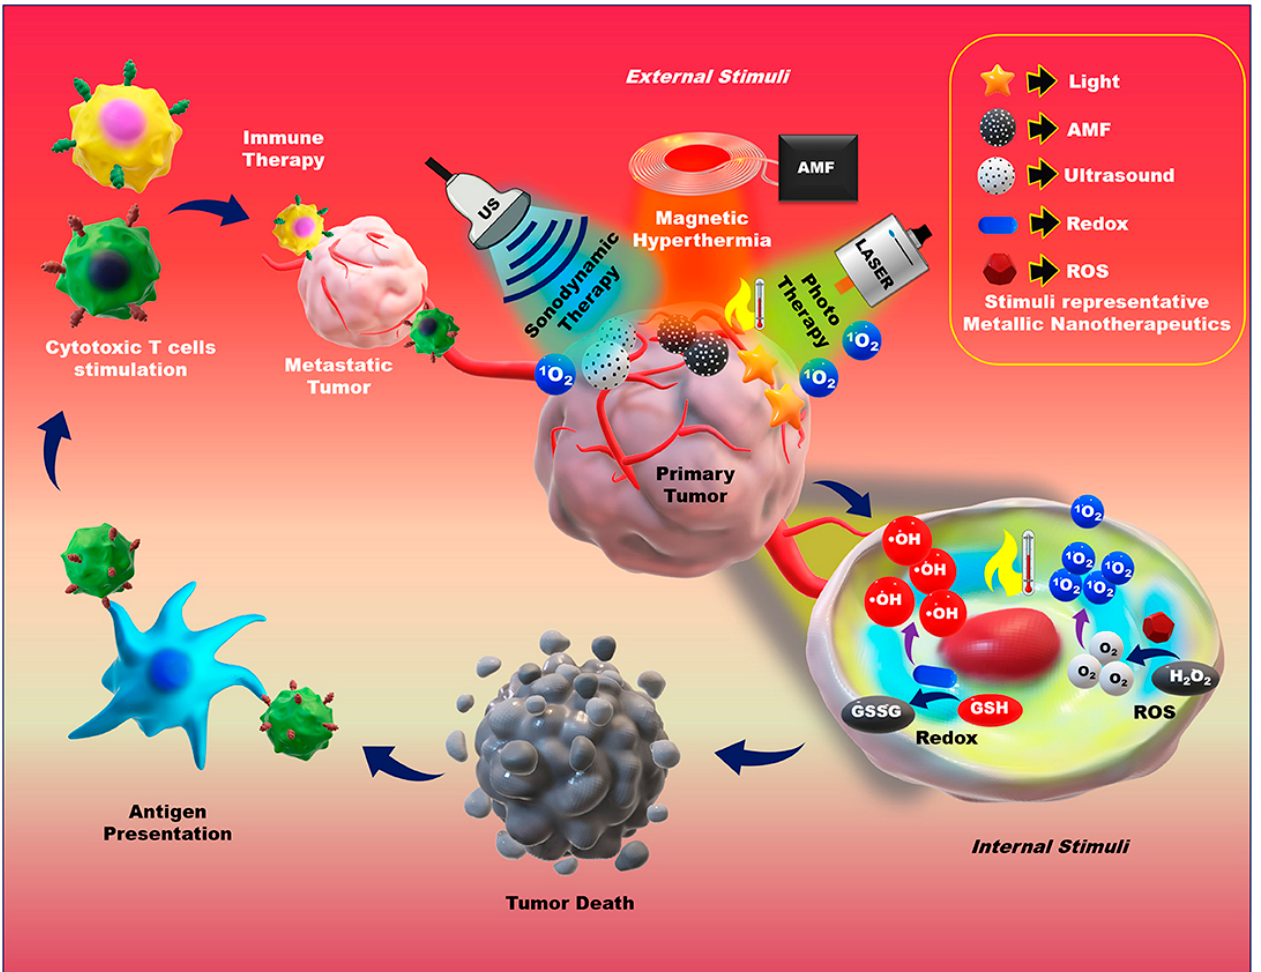
Figure 6. Application of external and internal stimuli-triggered metallic nanotherapeutics for cancer treatment. Reprinted from an open-access source [65]. Abbreviations: AMF—alternative magnetic field; GSH—glutathione; GSSG- glutathione disulfide; ROS—reactive oxygen species; US—ultra- sound.